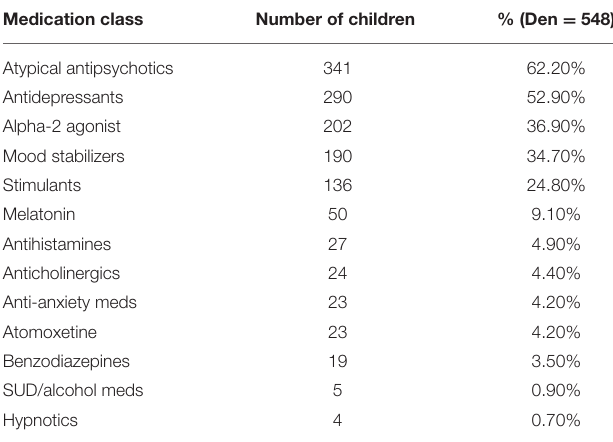
TABLE 2 | Psychotropic medications at admission.